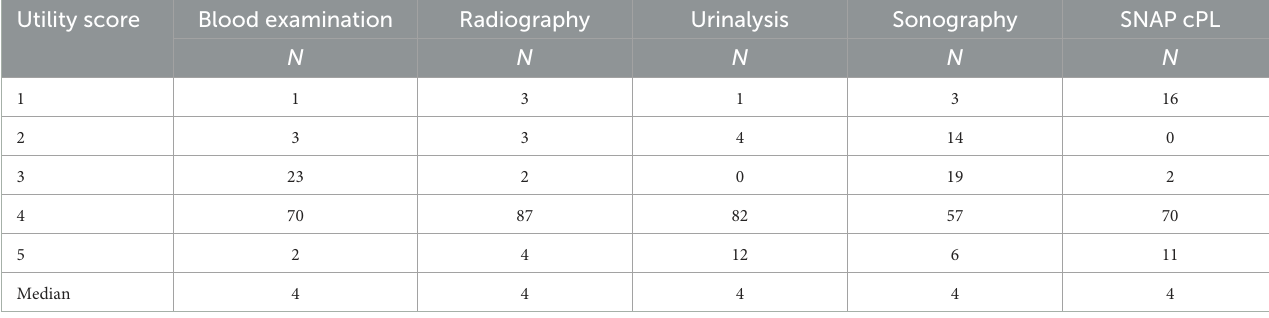
TABLE 2 Utility score of different diagnostic tests in 99 dogs with vomiting.